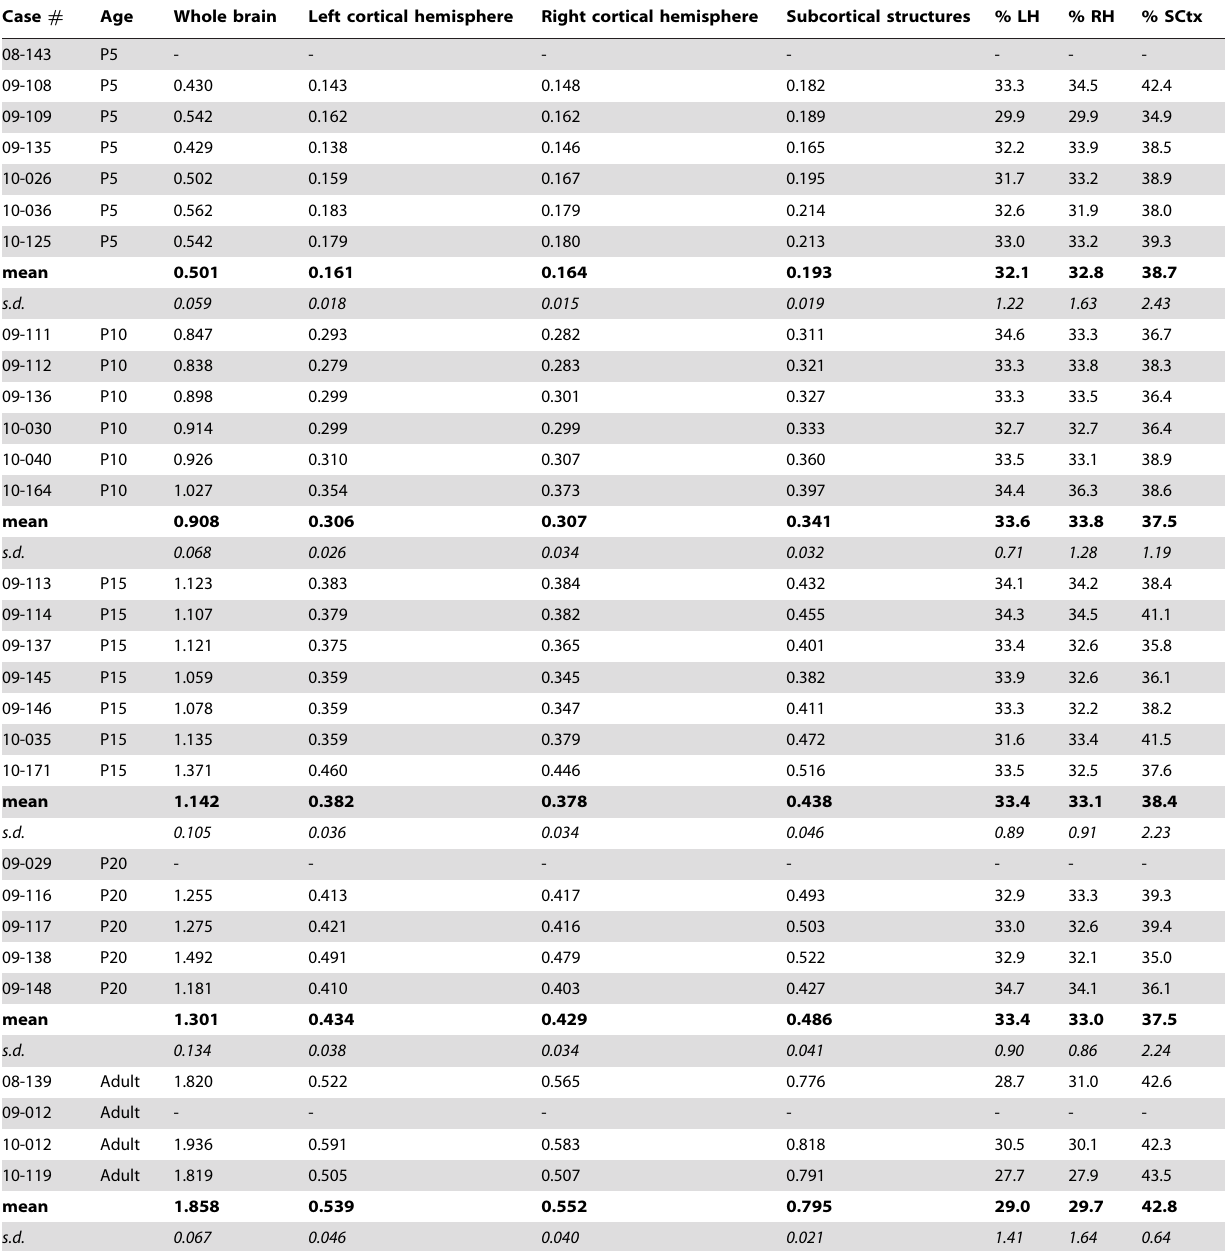
Table 3. Brain Weights in